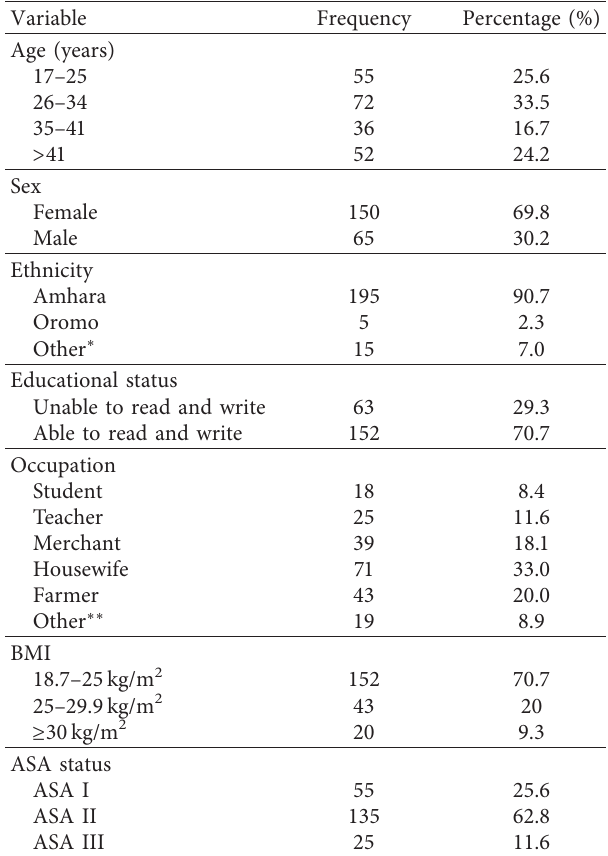
Table 1: Sociodemographic characteristics of the study participants who underwent the surgical procedure under spinal anesthesia at the University of Gondar Comprehensive and Specialized